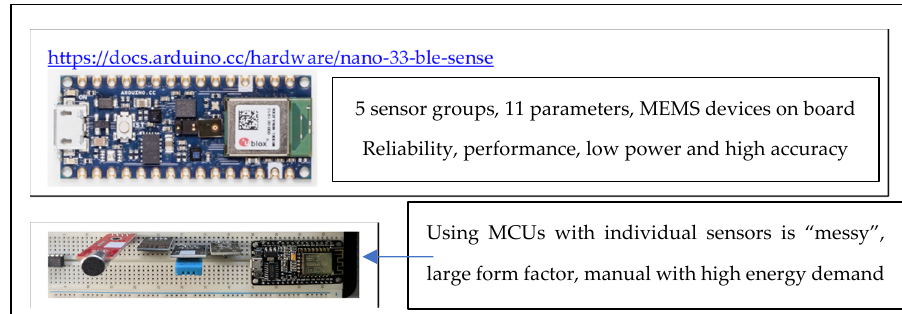
Figure 10. MCU features and choices.